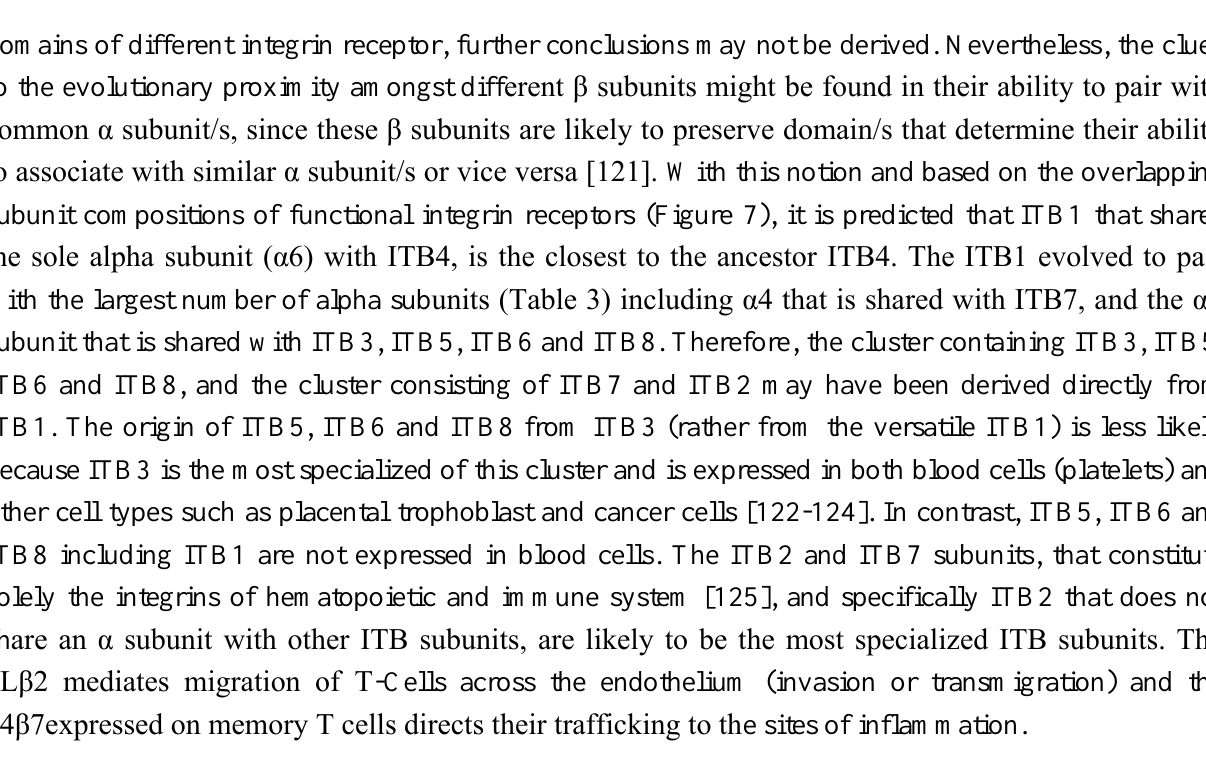
Table 3. Multiplicity and specificity of ligand binding by ITB subunits; ECM refers to extracellular matrix. ECM or Ligand  Integrin